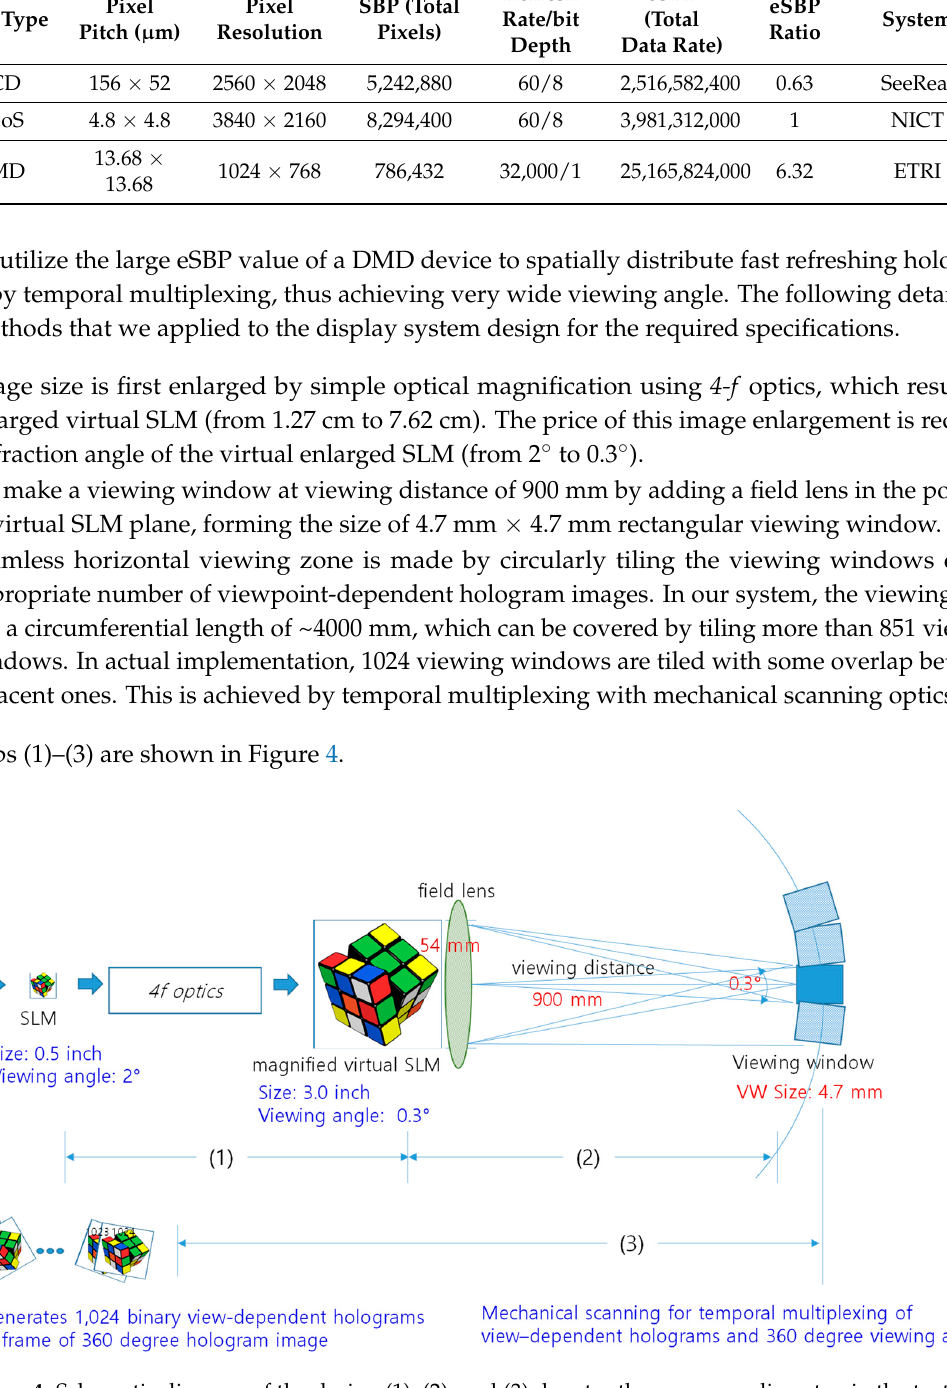
Table 3. Comparison of SBP and eSBP for different SLM devices.